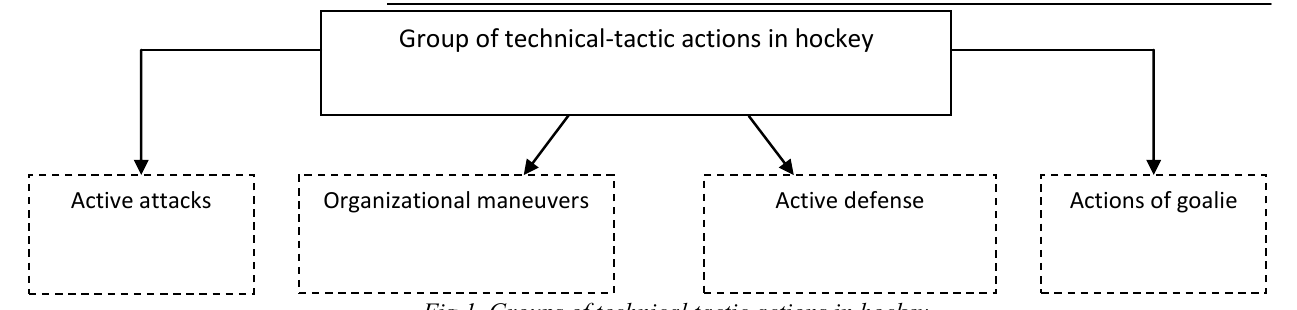
Fig.1. Groups of technical tactic actions in